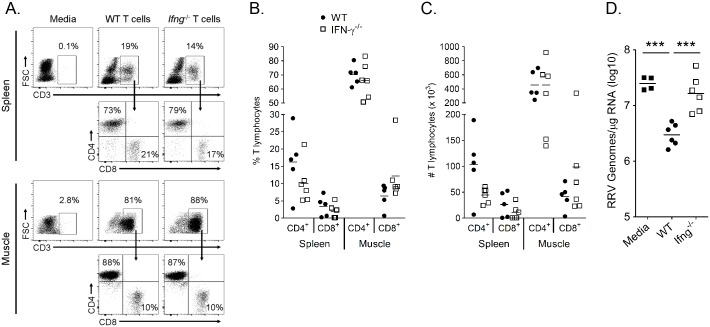
IFN-γ expression by T cells is required to control RRV infection in Rag1
-/- mice.T cells were isolated from the spleens of 6–8 week-old WT and Ifng
-/- mice via negative selection and 2.5 x 106 T cells were adoptively transferred into three-to-four week-old Rag1
-/- mice i.p. one day prior to inoculation with 103 PFU of RRV. (A-C) At 14 dpi, spleen and left quadriceps muscle tissues were harvested for flow cytometric analysis of the presence of T cells. (A) Representative flow plots showing the frequency of CD3+ and CD4+ or CD8+ T cells in the spleen and muscle tissues of Rag1
-/- mice that received either WT T cells or Ifng
-/- T cells. Quantification of the (B) frequency and (C) total number of CD4+CD3+ or CD8+CD3+ T cells in the mice that received T cells. Horizontal bars indicate the mean. (D) At 14 dpi, the right quadriceps muscle was dissected, total RNA was isolated, and RRV genomes were quantified by absolute RT-qPCR. Horizontal bars indicate the mean. Data are combined from 2 independent experiments. P-value was determined by a two-way, unpaired t-test.